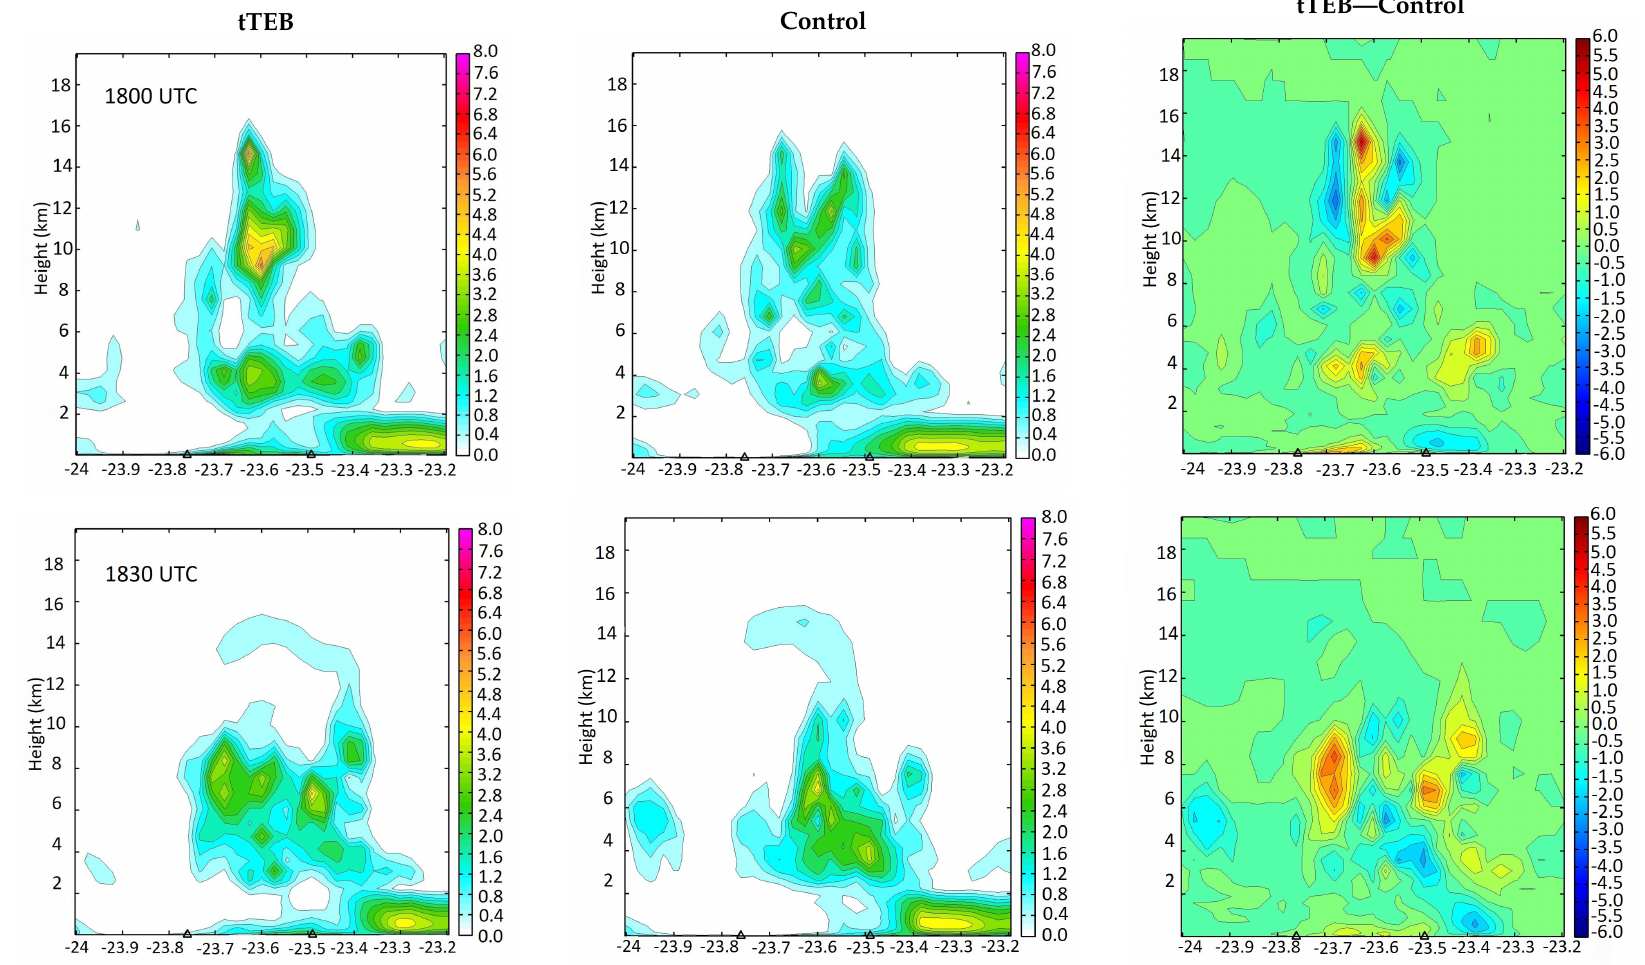
Figure 19. Vertical cross section of mean TKE (m 2 s − 2 ) between 46.9 ◦ W and 46.42 ◦ W at (first row) 18 UTC (15 LT) and (second row) 1830 UTC (1530 LT). The first column shows the results of the tTEB experiment, the second column shows results of the control experiment, and the third column show the difference between both experiments. Triangles indicate the extension of urban canopy of the